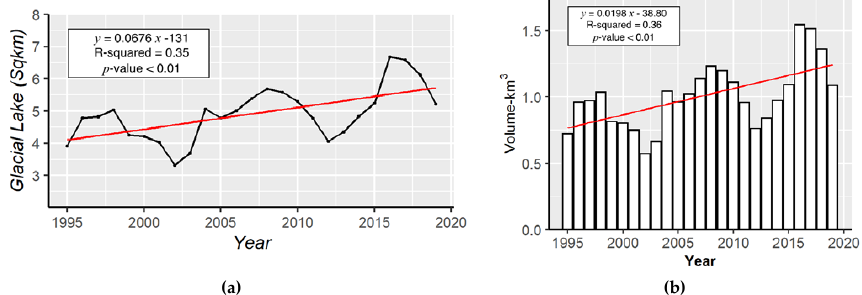
Figure 6. Glacial lake: ( a ) change in surface area; ( b ) changes in lake